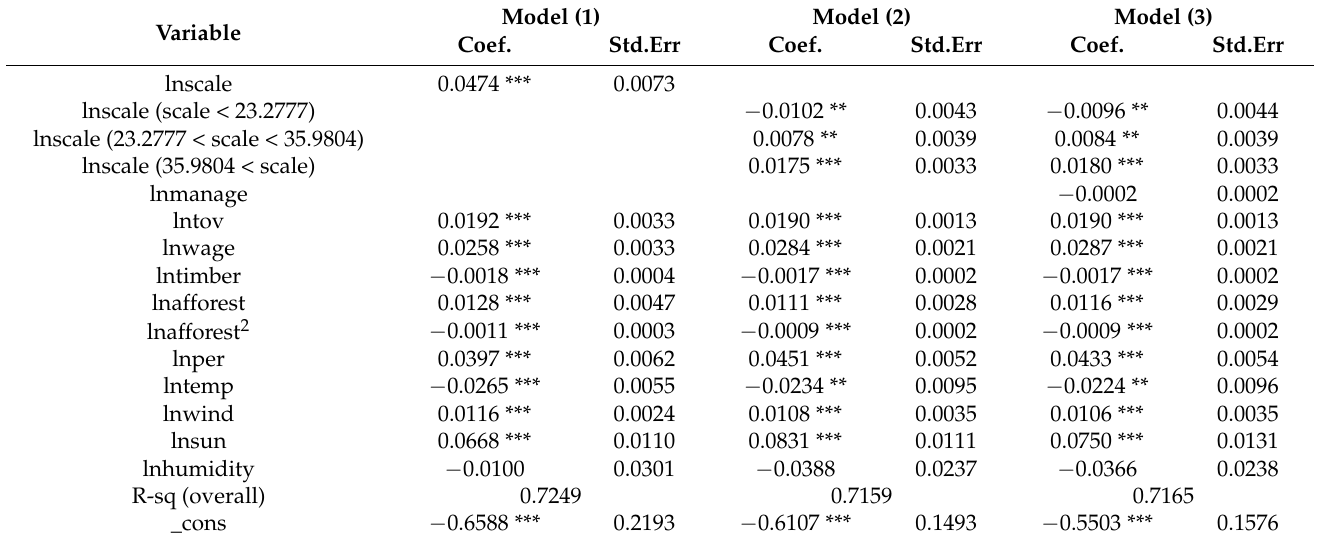
Table 6. Analysis of factors influencing carbon sequestration technical efficiency and the threshold effect of management